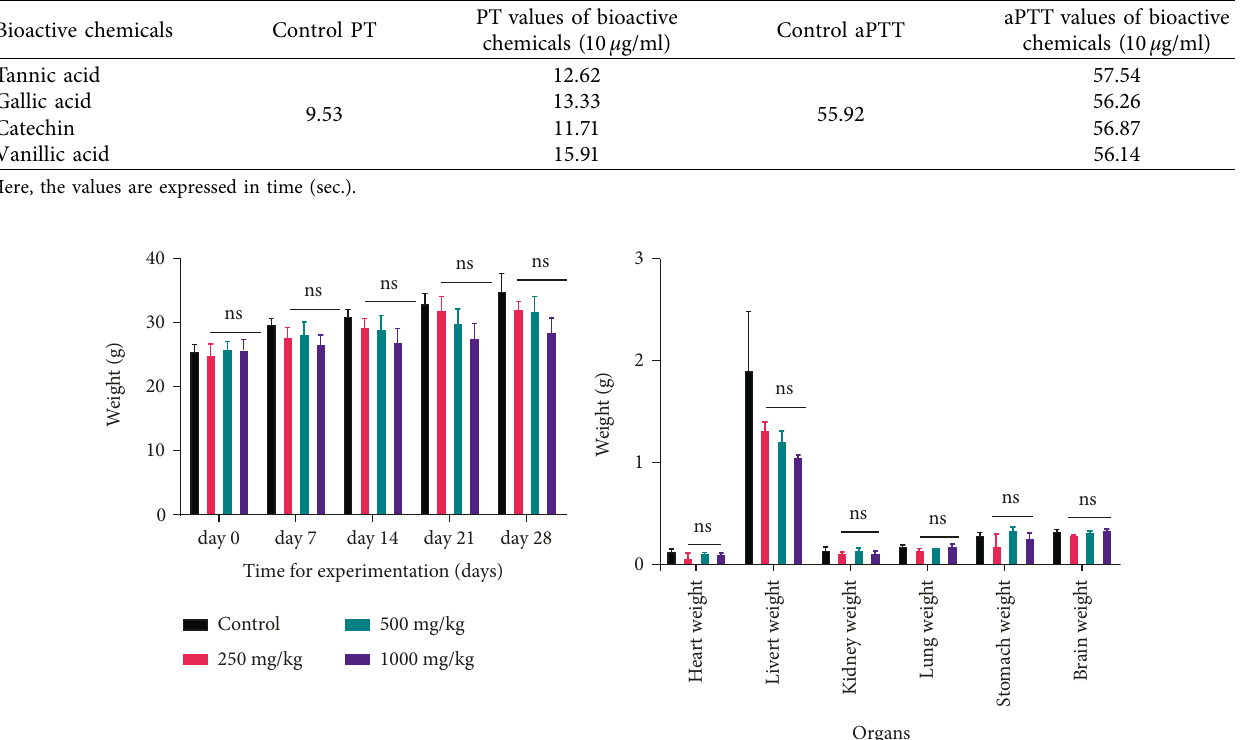
Table 4: Anticoagulant activity of the bioactive chemicals derived from A. philoxeroides Bioactive chemicals